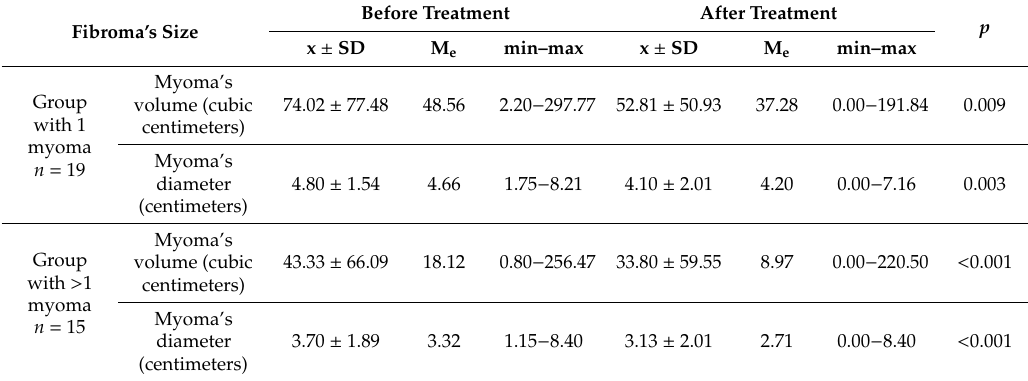
Table 3. The diameter and volume of fibroids before and after 3 months of treatment with ulipristal acetate depending on the number of myomas: one myoma or multiple myomas.